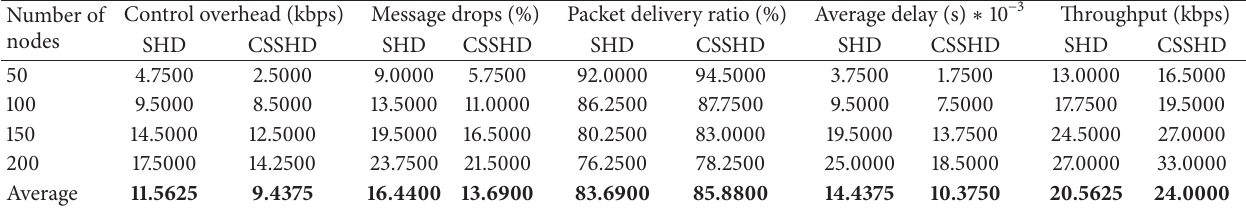
Table 3: Performance of proposed method and the existing method based on the number of nodes.